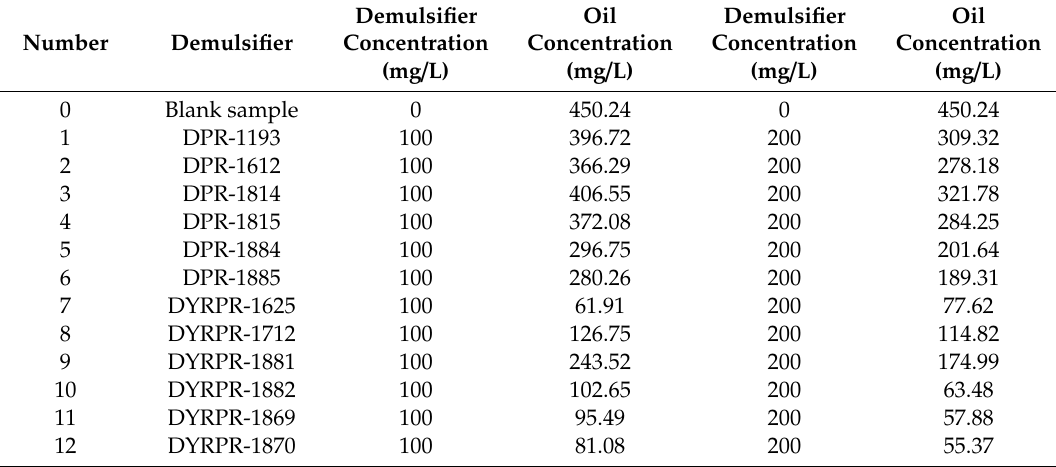
Table 2. E ff ect of di ff erent demulsifiers on alkaline–surfactant–polymer (ASP) flooding-produced